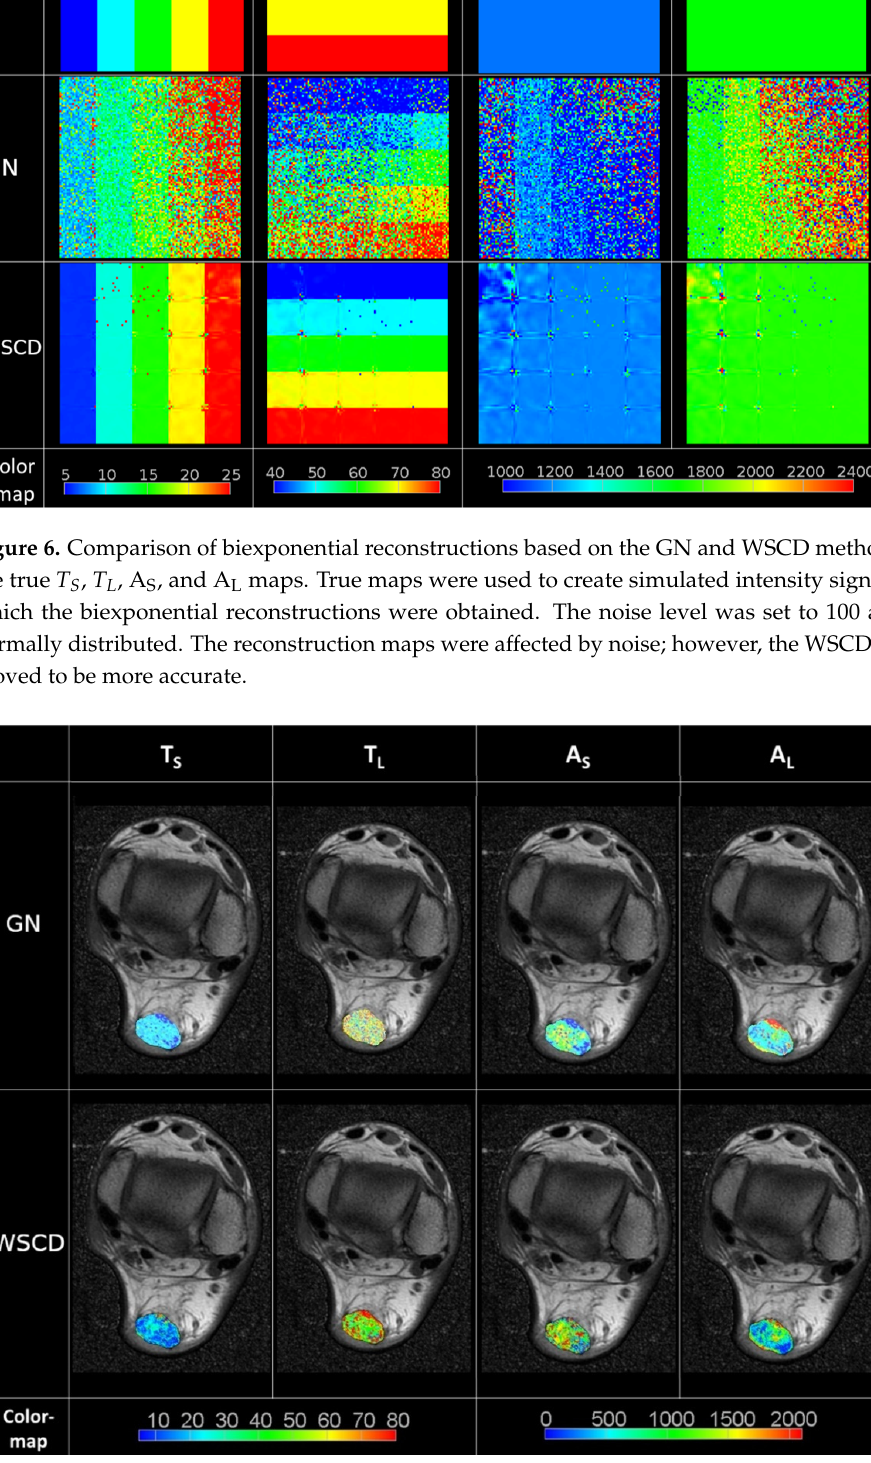
Figure 7. Comparison of biexponential reconstruction methods based on segmented AT regions in MRIs. The segmented and reconstructed AT regions were imposed on the initial MRI.